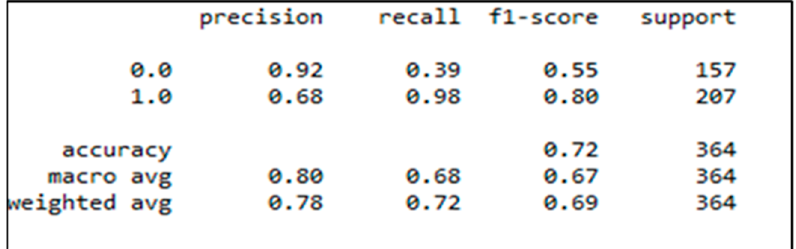
Figure 5. Classification matrix for the emotion module and the human aura module.